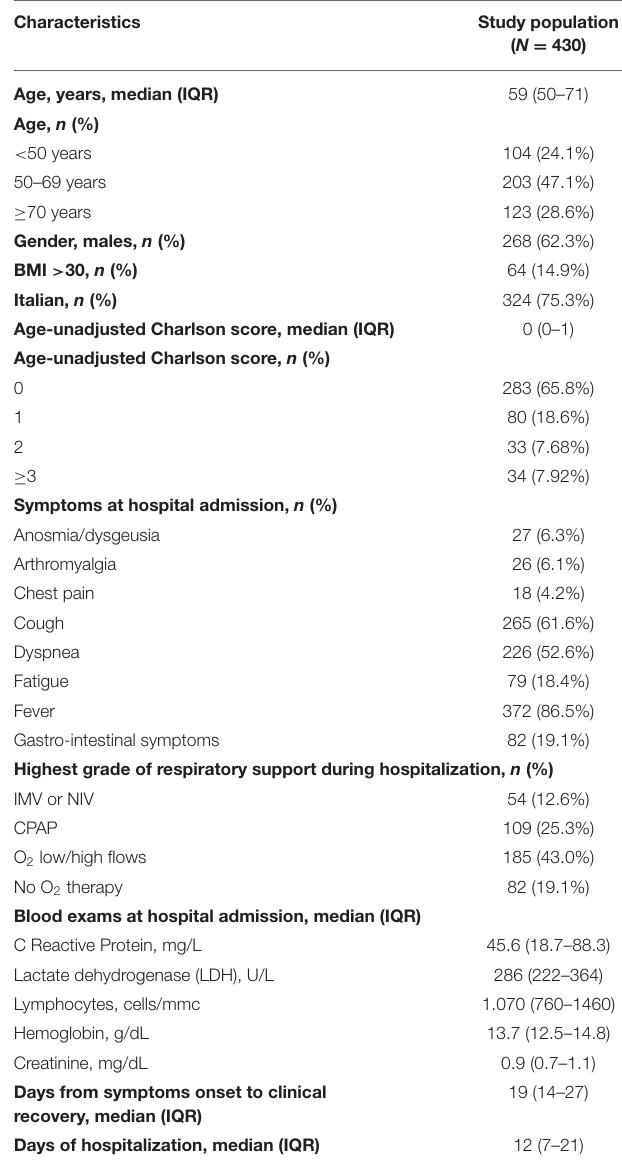
TABLE 2 | Characteristics of study